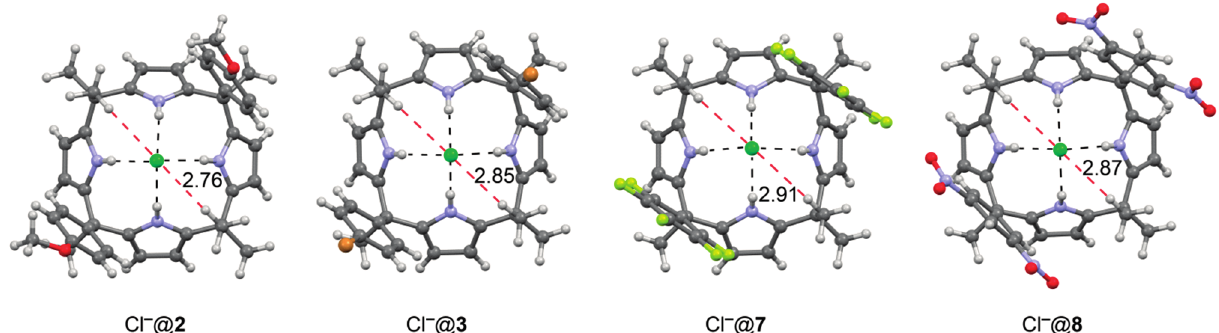
Figure 4. X-ray geometries of chloride complexes with receptors 2 , 3 , 7 and 8 . Distances are indicated in Å. The CH···Cl − interactions are marked using a red dashed